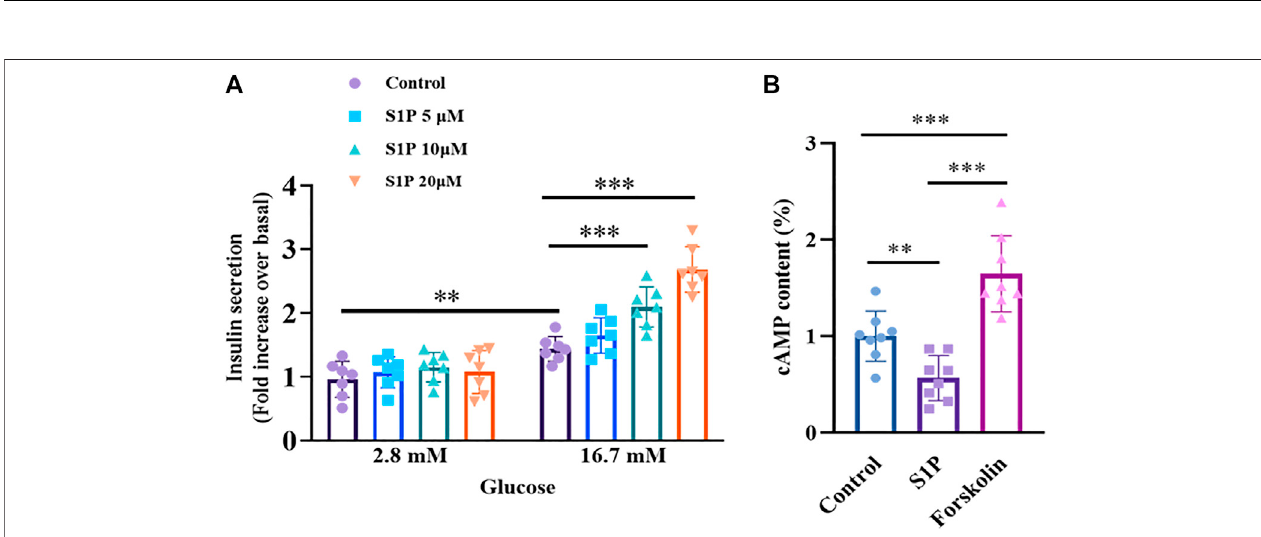
FIGURE2| Effectsofsphingosine1-phosphate(S1P)onglucose-stimulatedinsulinsecretionandintracellular cAMPproductioninratislets. (A) Inductionofinsulin secretion by S1P under low- and high-glucose conditions (2.8 and 16.7 mM, respectively). The insulin secretion of each group was normalized by that of the control group with 2.8 mM glucose ( n (cid:2) 7). (B) Effect of S1P (10 μ M) on rat islet cAMP levels. Forskolin (10 μ M) was used as positive control. Intracellular cAMP levels were normalized by the control group ( n (cid:2) 8). ** p < 0.01, *** p < 0.001; by one-way ANOVA. The results represent by the mean ± SEM.